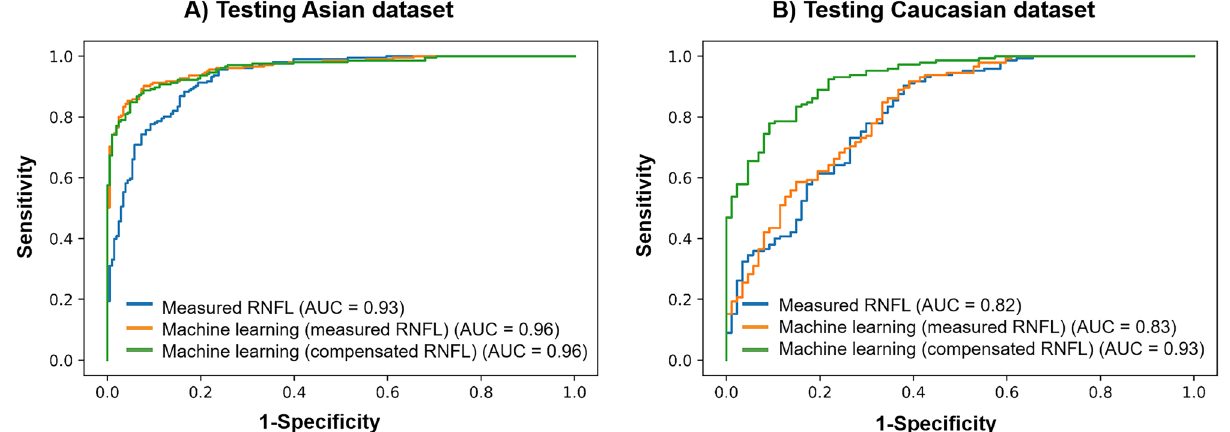
Figure 1. Receiver operating characteristic curves comparing glaucoma detection on the ( A ) Testing Asian dataset and ( B ) Testing Caucasian dataset using the measured retinal nerve fiber layer (RNFL), machine learning models using either measured RNFL thickness or compensated RNFL thickness. Values in brackets indicate the area under the curves (AUC) for the corresponding